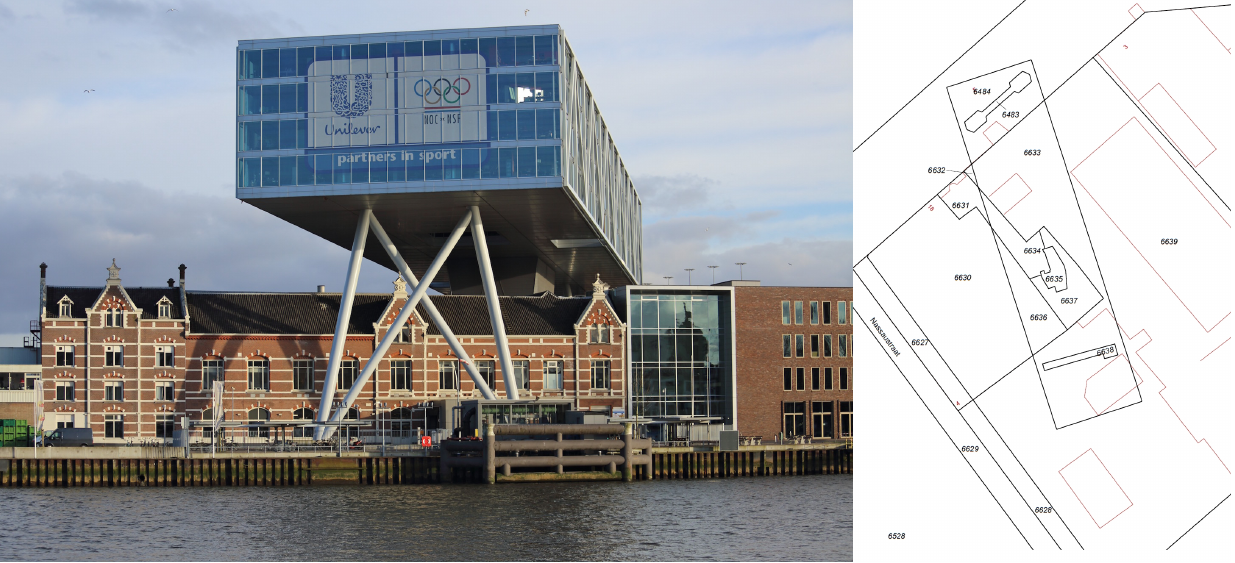
Figure 7. Example of a complex property situation (in Rotterdam, The Netherlands) in which the limitations of 2D cadastre are exposed. The corresponding cadastral map (courtesy of the Dutch Kadaster) shows that multiple small parcels are necessary to register a single